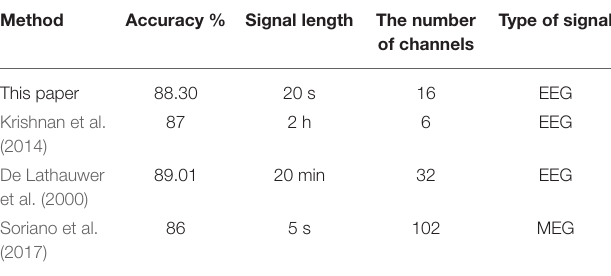
TABLE 5 | The epileptic detection accuracy and EEG signal length of this paper and other studies.